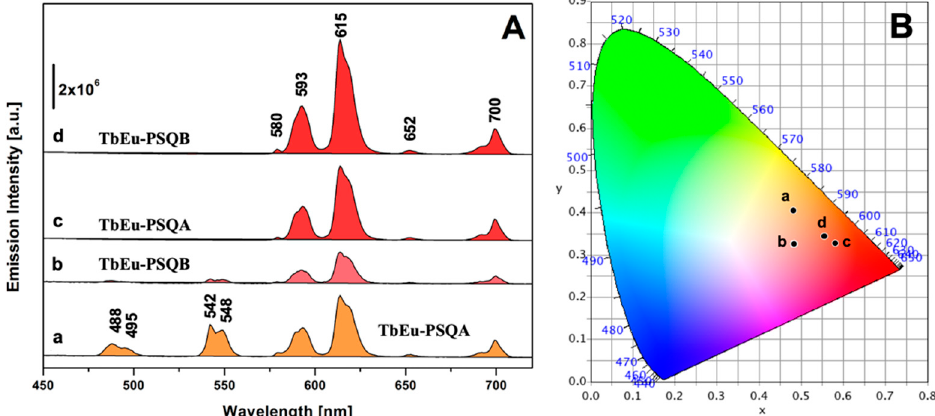
Figure 4. ( A ) Emission spectra of TbEu-PSQ solids excited at 270 nm (TbEu-PSQA, curve a; TbEu- PSQB, curve b) and at 395 nm (TbEu-PSQA, curve c; TbEu-PSQB, curve d). ( B ) CIE 1931 xy chroma- ticity diagrams derived from emission spectra in panel A. The xy coordinates of each spectrum are indicated in the diagram with a dot labelled with the same letter used in section ( A ). The color of each spectrum in section ( A ) corresponds to the xy coordinates identified in the CIE 1931 diagram.